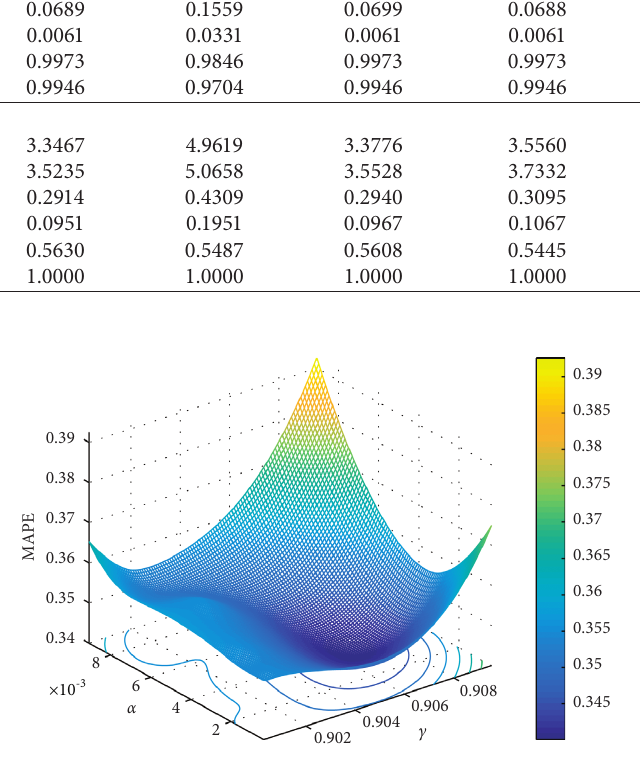
Figure 6: The relationship between MAPE and parameters.